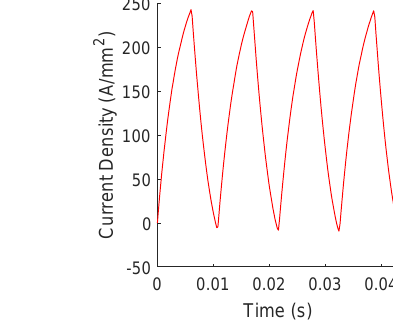
Figure 14. Example battery bank output: Added inductance: 1.672 mH, 36